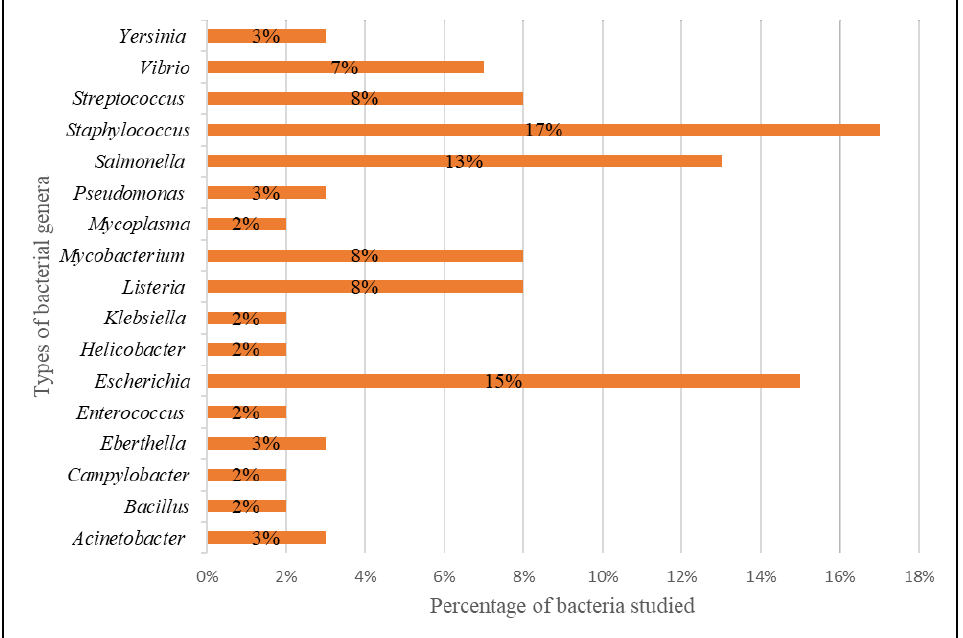
Figure 3. Bacteria from various genera were detected via CRISPR-Cas systems.